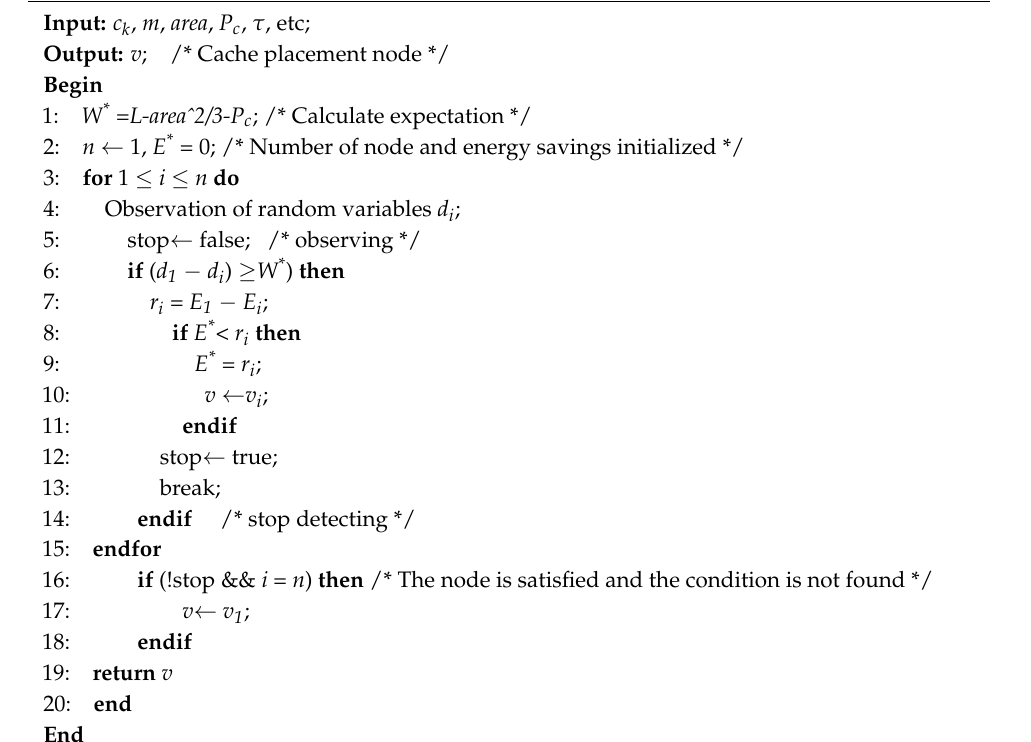
Algorithm 1. ESCPS